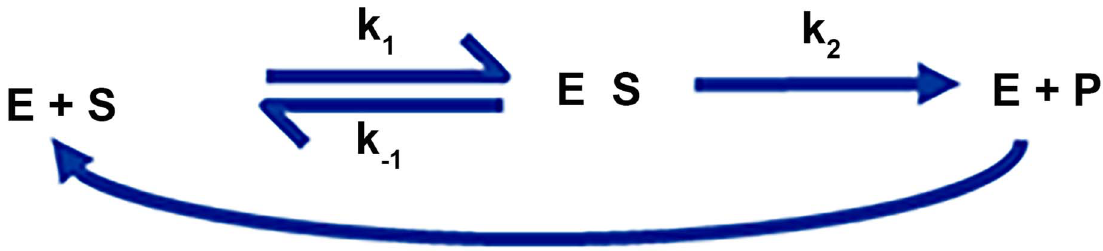
Fig. 1. Diagram of a typical Michaelis-Menten reaction, in which an enzyme, E, catalyzes the conversion of a substrate, S, into a product, P, via the formation of an intermediate complex, ES. The indexed quantities, k , denote reaction rates. Specifically, the intrinsic growth or decay process of each variable P i is captured as a univariate mass action function, and the interactions between each pair of popula- tions P i and P j follow the typical mass action law for two substrates. The struc- ture of Lotka-Volterra models looks de-